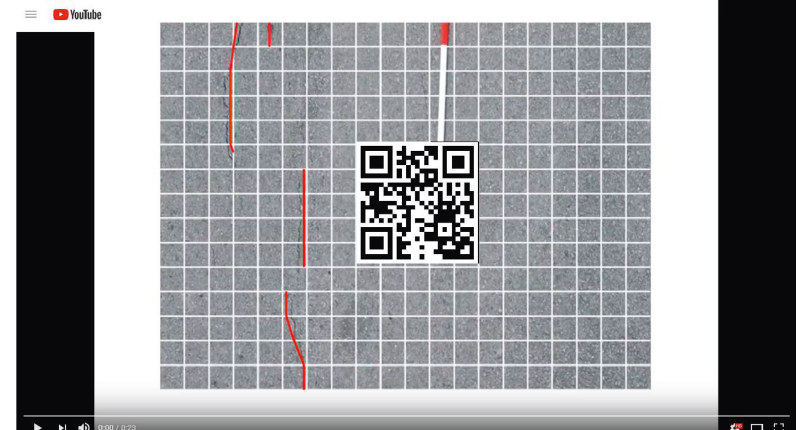
Figure 18: The real-time video of CMA is available at this link: https://youtu.be/SGh03B5EEpk. Table 1: Retraining the CNN by changing the HPs to validate the calculated values by the BOA. Changing the HPs